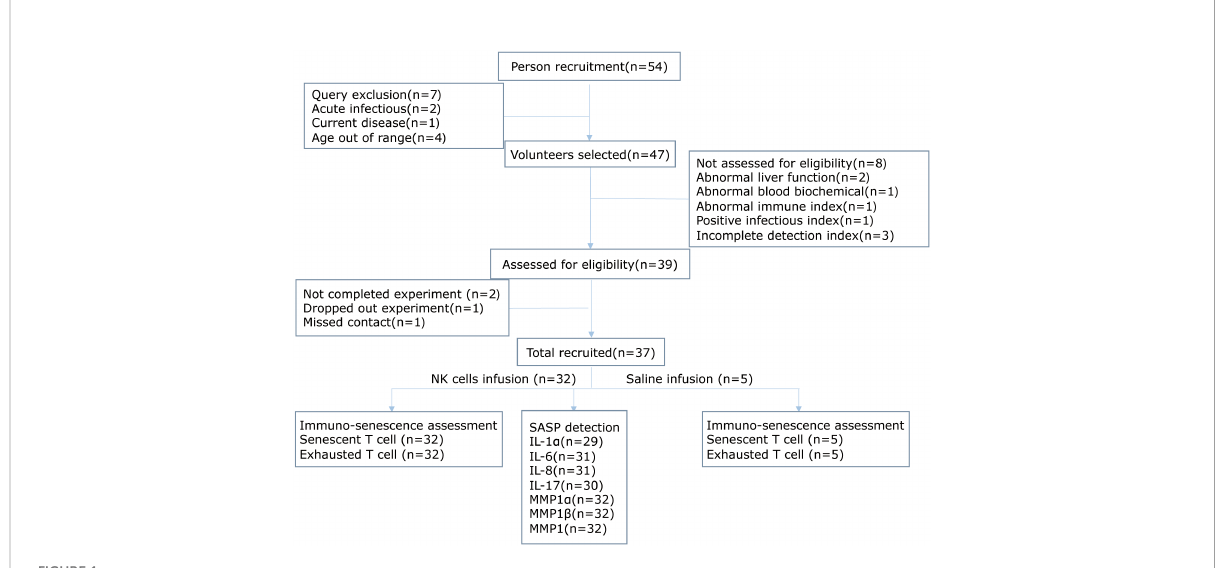
FIGURE 1 The study fl owchart in line with the